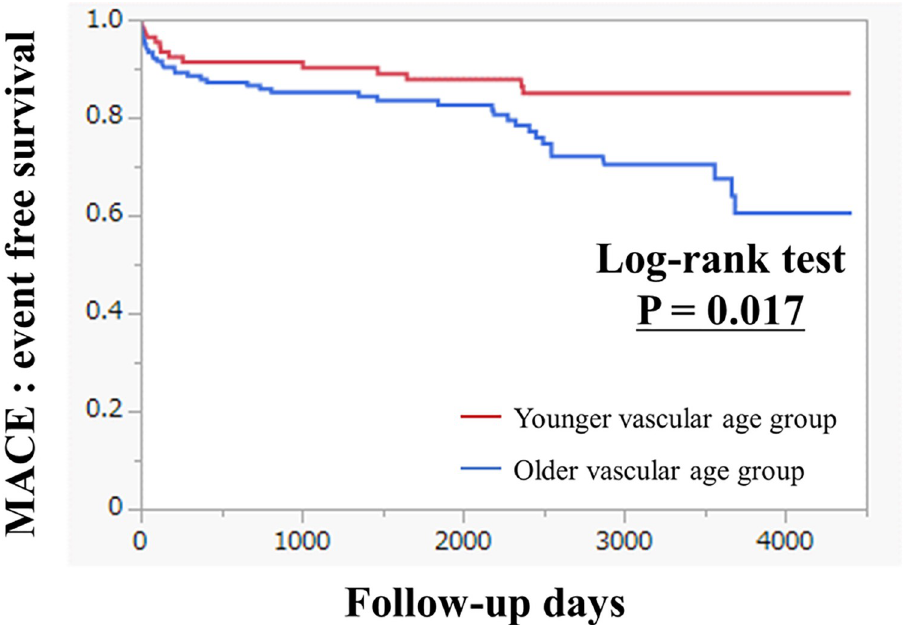
Fig 5. Kaplan-Meier curves for major adverse cardiovascular events (MACE) in the younger vascular age group and older vascular age group.